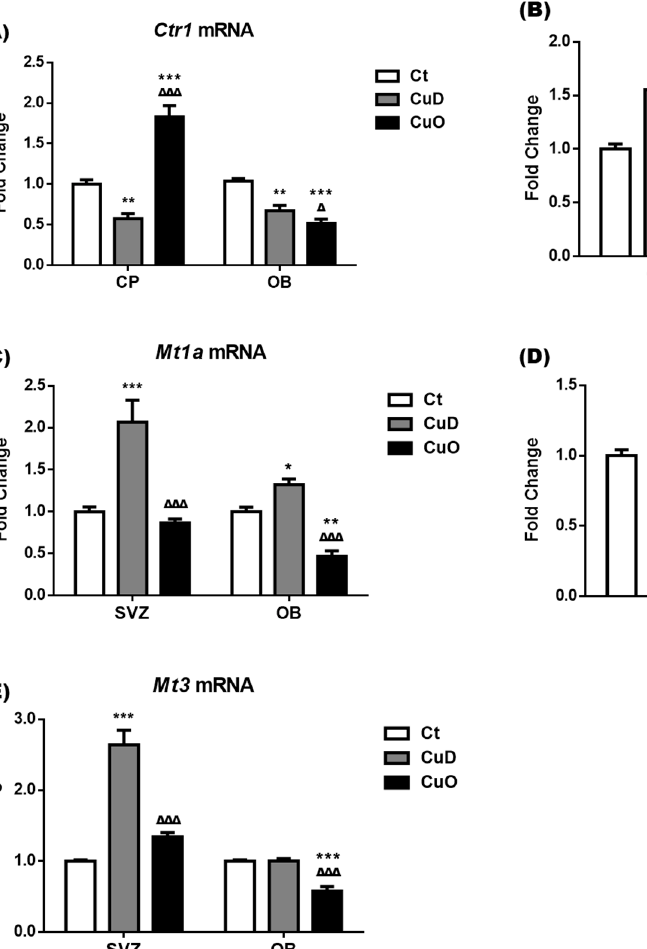
Figure 9. Expression of Cu regulatory mRNAs following CuD or CuO treatment. Expressions of mRNAs encoding Cu regulatory proteins were quantified by qPCR. ( A ). Ctr1 mRNA expressions in the choroid plexus (CP) and OB. ( B ). Dmt1 mRNA expressions in the CP and OB. ( C ). Mt1a mRNA expressions in the SVZ and OB. ( D ) Mt2a mRNA expressions in the SVZ and OB. ( E ) Mt3 mRNA expressions in the SVZ and OB. Data represents mean ± SEM, n = 6–7/group. *: p < 0.05, **: p < 0.01, ***: p < 0.001, as compared to the correspondent Ct group; ∆ : p < 0.05, ∆∆∆ : p < 0.001, as compared with the correspondent CuD group; using one-way ANOVA analysis. Ct: control; CuD: Cu deficiency; CuO: Cu overload; SVZ: subventricular zone; OB: olfactory